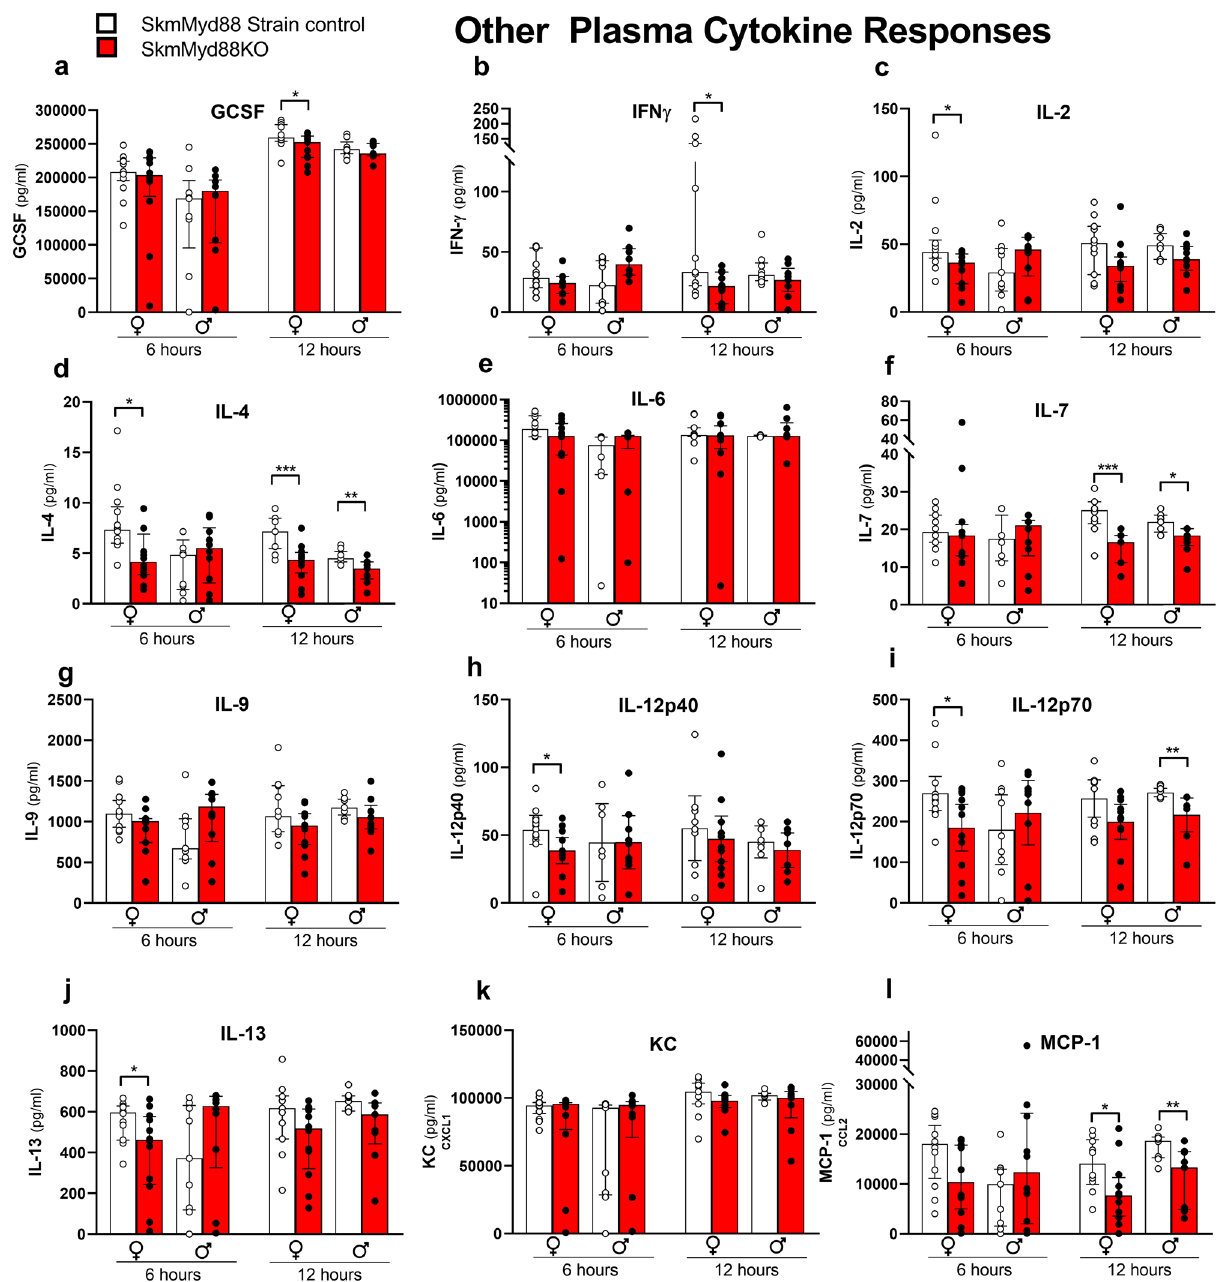
Figure 3. Other cytokine responses to skmMyd88 knockout. SkmMyd88KO (red) vs SkmMyd88 strain controls (white). Unpaired comparisons were within strains and sexes *P < 0.05, **P < 0.01. n = 9–12 in each group. Data expressed as medians ± 25–75% quartiles. All data met a false discovery rate of <